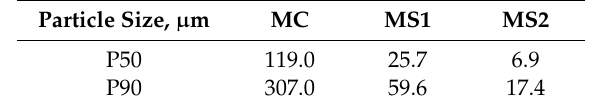
Table 2. Particle size estimated by optical microscopy and laser di ff raction technique.